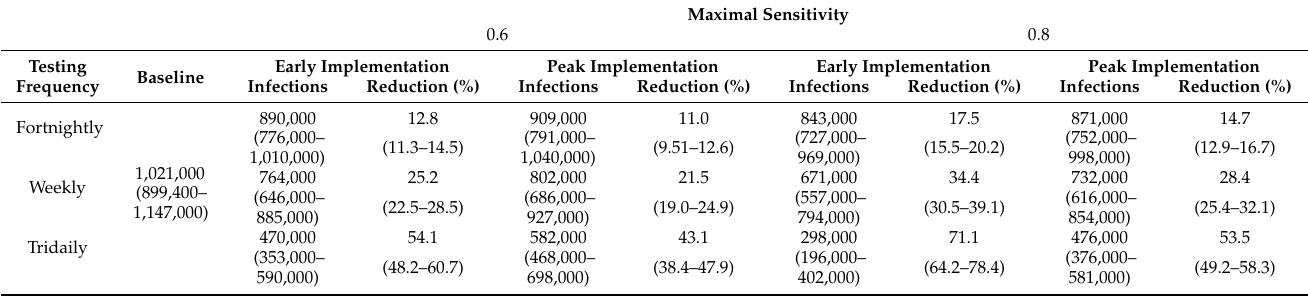
Table 1. Infections and reduction relative to baseline scenario at 0.8 maximal test